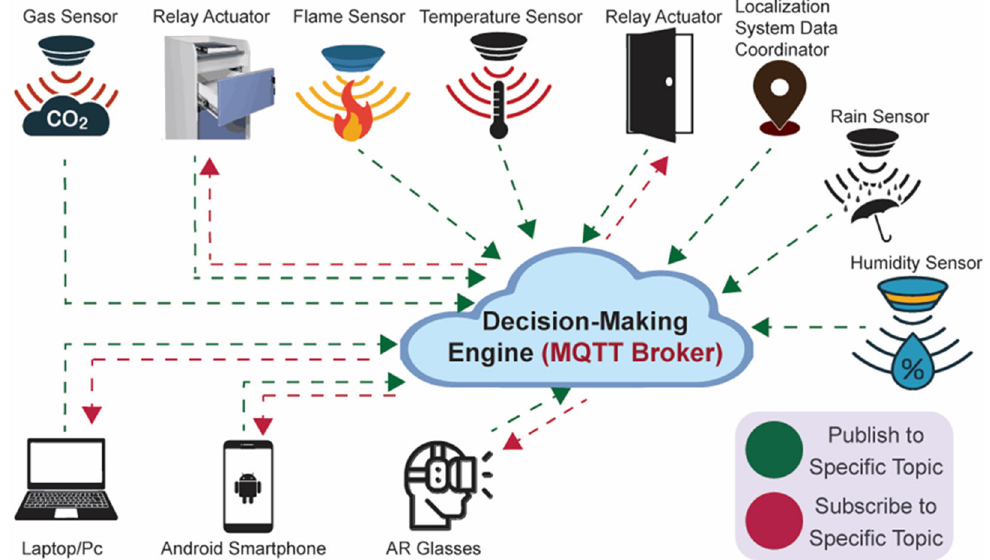
Figure 2. MQTT protocol operation in the AAL system. All the data and status of the smart devices will be transmitted/subscribed on a specific topic to the cloud. The user interaction within the AR environment can be rendered by AR glasses or mobile phone.